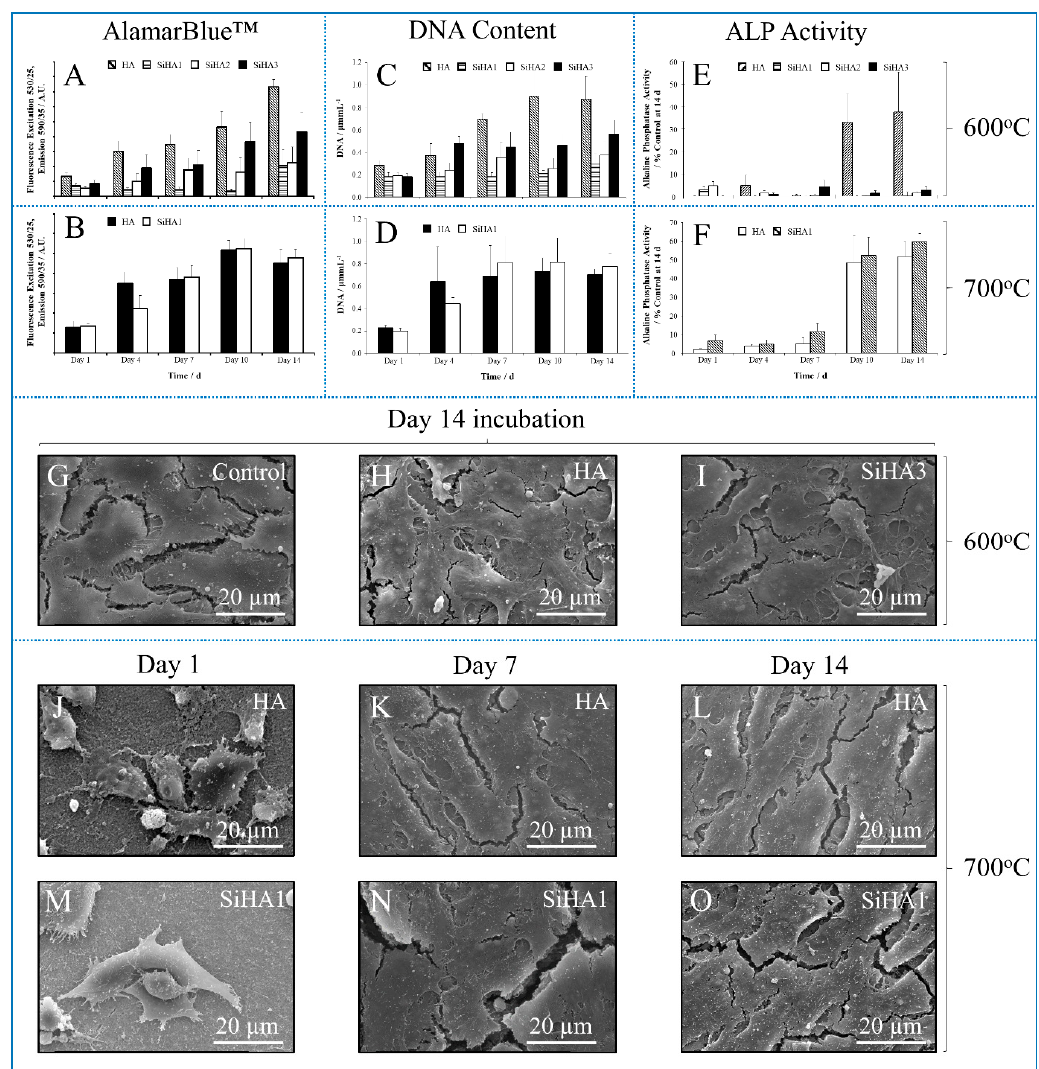
Figure 12. Combined cellular proliferation data showing: AlamarBlue™ assay of HOBs on HA and SiHA surfaces heat treated at ( A ) 600 °C and ( B ) 700 °C; DNA content of HOBs on HA and SiHA surfaces heat treated at ( C ) 600 °C and ( D ) 700 °C; ALP activity of HOBs on HA and SiHA surfaces heat treated at ( E ) 600 °C and ( F ) 700 °C (All graphs are plotted with mean ± standard error of the mean where n = 6); SEM micrographs of cellular morphology showing 14 day incubation on 600 °C annealed ( G ) Thermanox (Control), ( H ) HA, and ( I ) SiHA3; Further SEM micrographs of cell morphology on 700 °C annealed HA and SiHA1 samples incubated at day ( J ),( M ) 1, ( K ),( N ) 7 and ( L) ,( O ) 14, respectively.